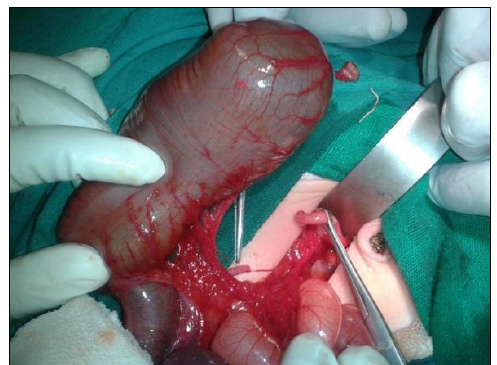
Figure 2: Transverse colonic atresia after ligation of umbilical